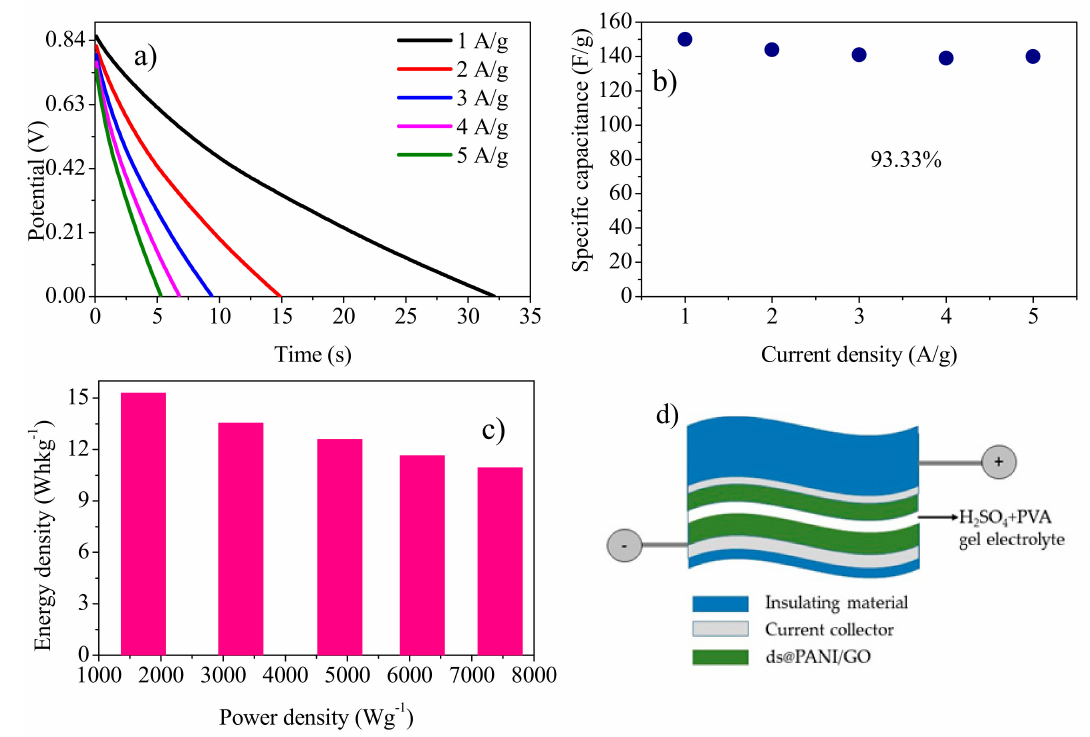
Figure 10. ( a ) Discharge curve of the solid-state symmetric device at various current densities. ( b )Specificcapacitanceasafunctionofcurrentdensity. ( c )TheRagoneplot. ( d )Schematicrepresentation of the solid-state symmetric device.